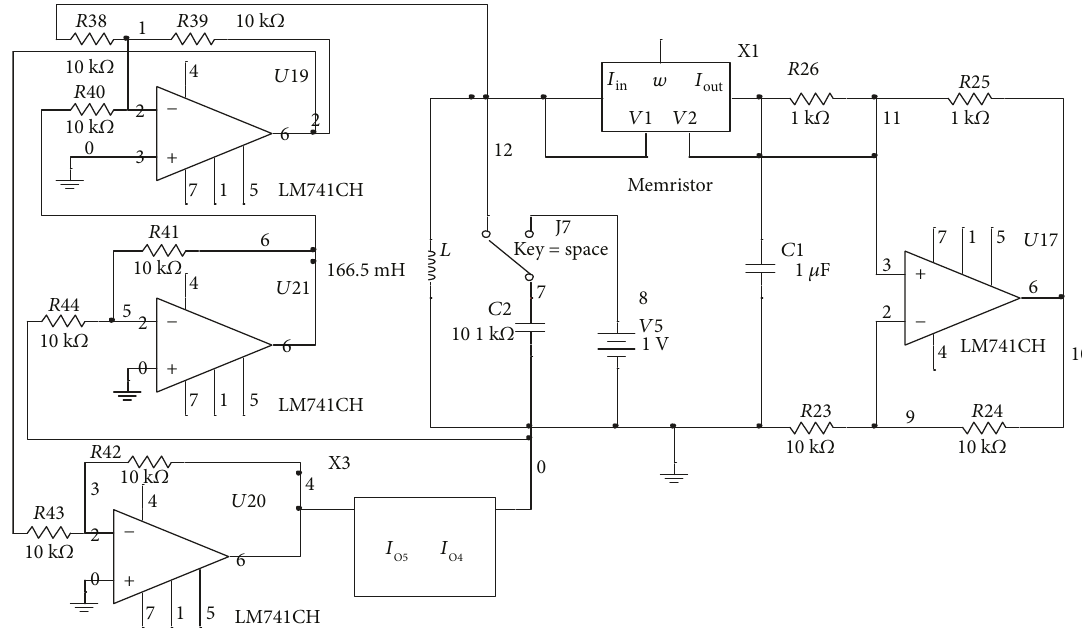
Figure 14: Circuit diagram of the multiscroll hyperchaotic